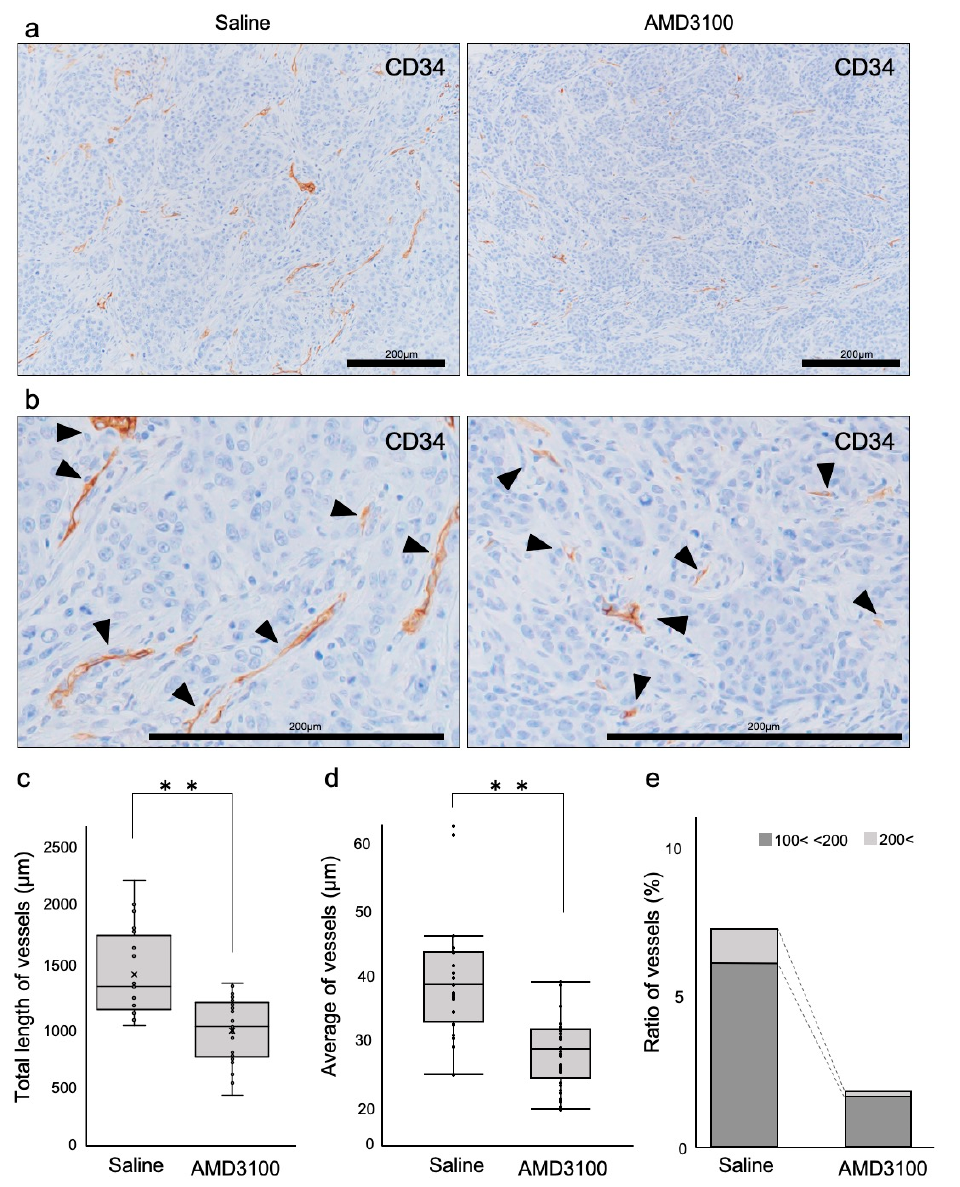
Figure 6. Tumor vessels were disorganized by CXCR4 antagonism. ( a ) Low-power magnification IHC of CD34. ( b ) High-power magnification IHC of CD34. ( c ) The total length of CD34-positive vessels. ** p < 0.0001, N = 25. ( d ) The average length of CD34-positive vessels. ** p < 0.0001, N = 25. ( e ) Rate of vessels sized 100~200 μ m, and >200 μ m.